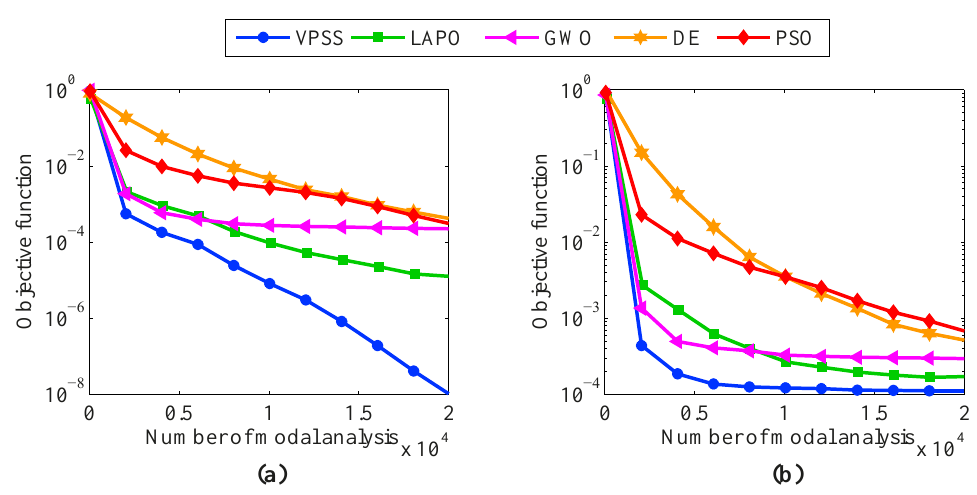
Figure 7. Convergence histories of mean objective function values of VPSS, LAPO, GWO, DE, and PSO for the 47-bar planar truss in the ( a ) noise-free condition and ( b ) noisy condition.